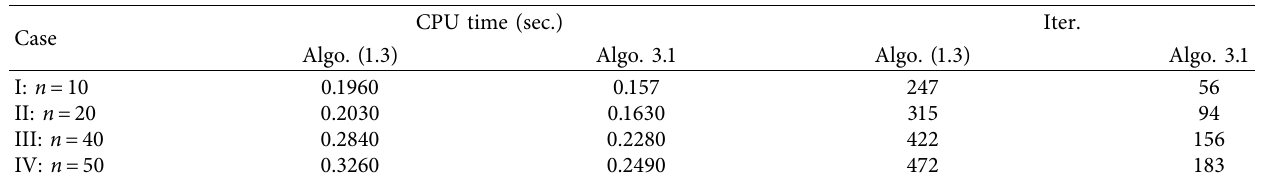
Table 1: Computation result for the example.